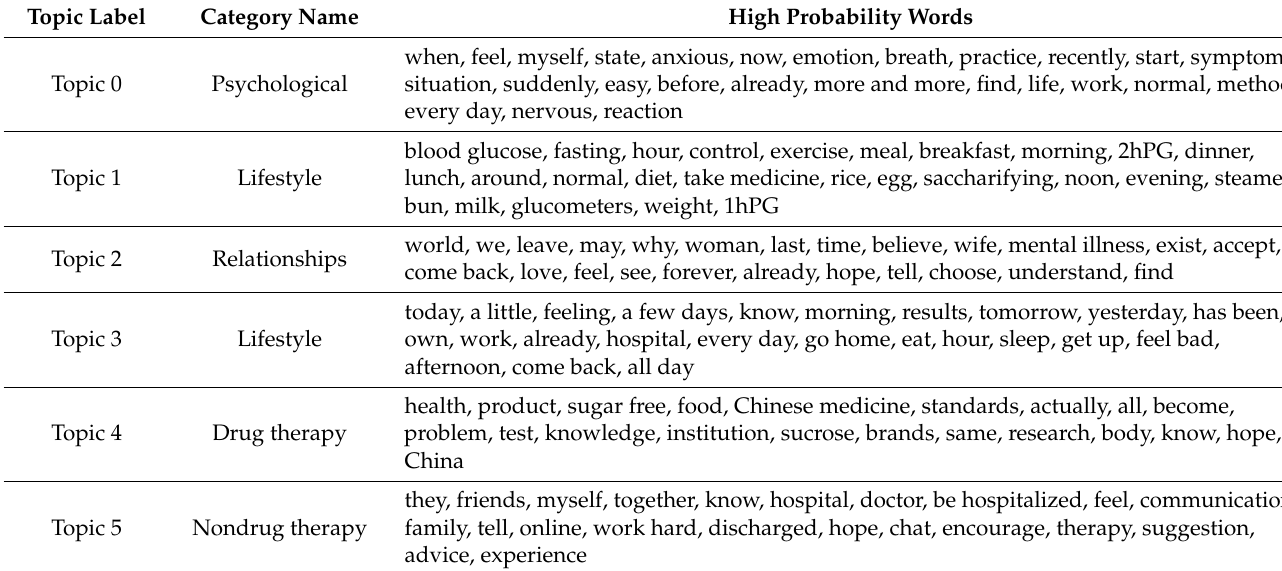
Table A1. High probability words in each LDA